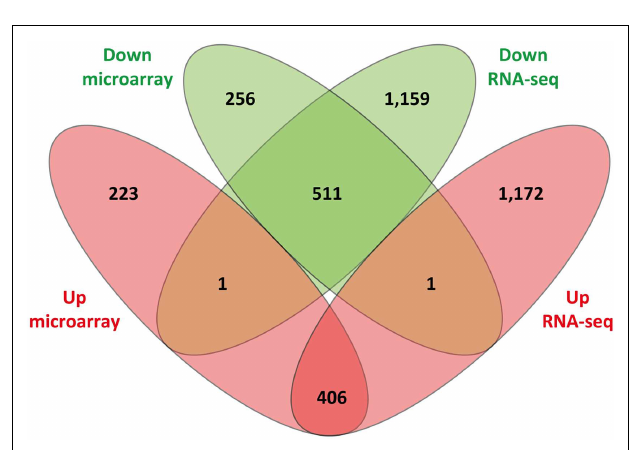
FIGURE 4 |Venn diagram showing comparison of differentially expressed genes identified from sense RNA-seq data and the microarray . Sets of upregulated genes are represented in red and sets of downregulated genes are in green.